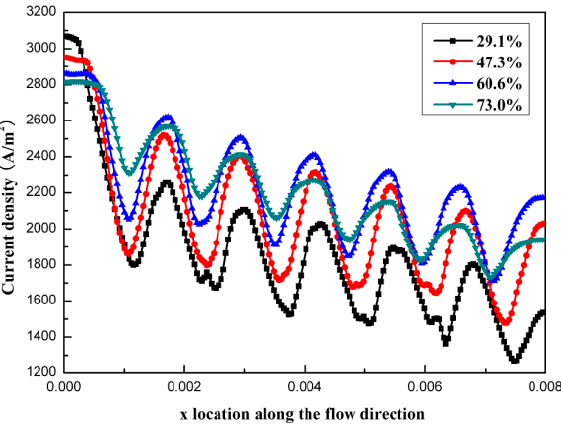
Figure 6. Current density distributions at the catalyst layers along the x direction under the conditions of different open ratios.